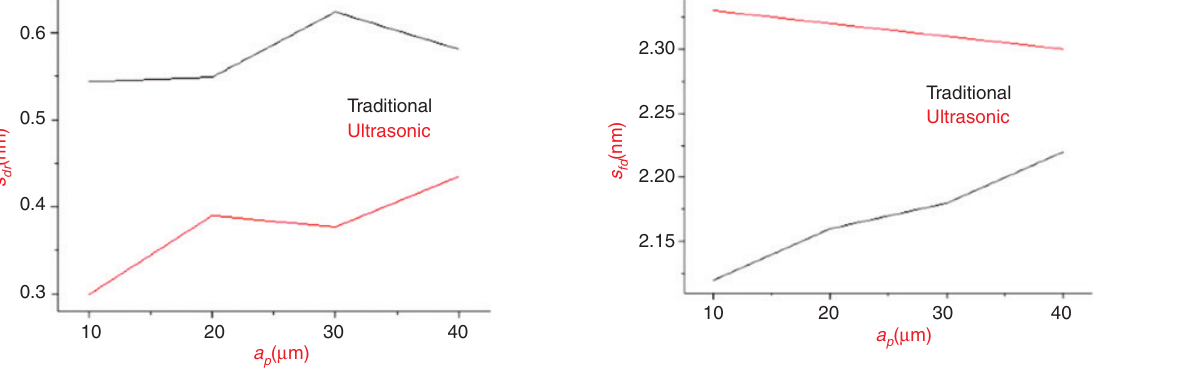
As is shown in Figure 8, the root mean square increases as the grinding penetrates deeper, which indi- cates that the surface becomes rougher. At the same time, the root mean square of surfaces after traditional grinding is larger than that after ultrasonic grinding. The surface is relatively rough after traditional grinding and it is smooth after ultrasonic grinding, as is shown in Figure